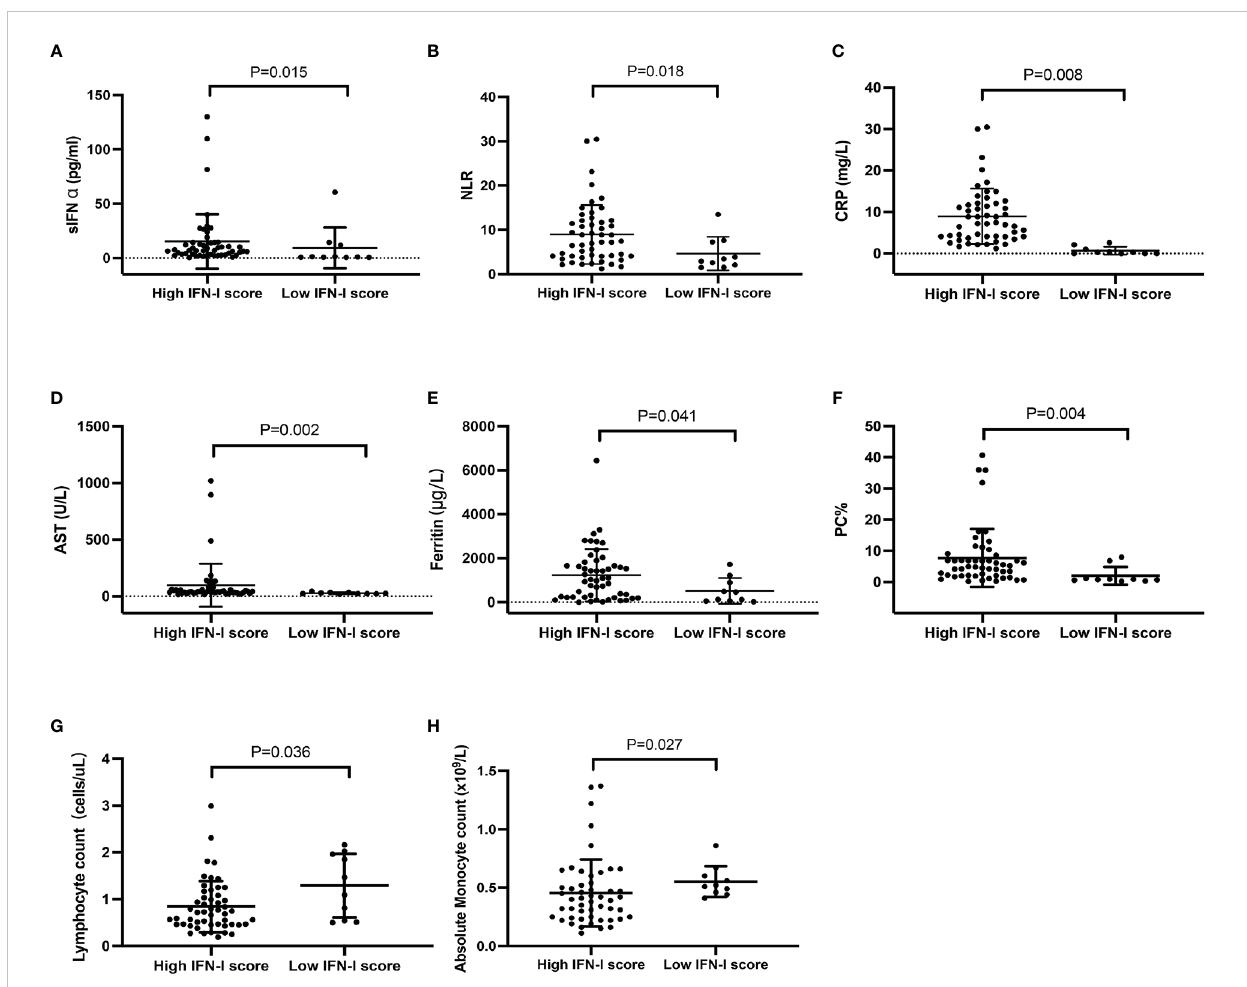
FIGURE 3 Comparison of laboratory data between patients with anti-MDA5+ DM in the high (n = 51) and low (n = 10) IFN-I score groups. (A) Serum IFN- a concentration, (B) NLR, (C) CRP concentration, (D) AST concentration, (E) ferritin concentration, (F) PC%, (G) lymphocyte count, and (H) absolute monocyte count. Comparisons were performed using the Mann – Whitney U test. The bars represent the mean ± SD. NLR, neutrophil-to-lymphocyte ratio; CRP, C ‐ reactive protein; AST, aspartate transaminase; PC, plasma